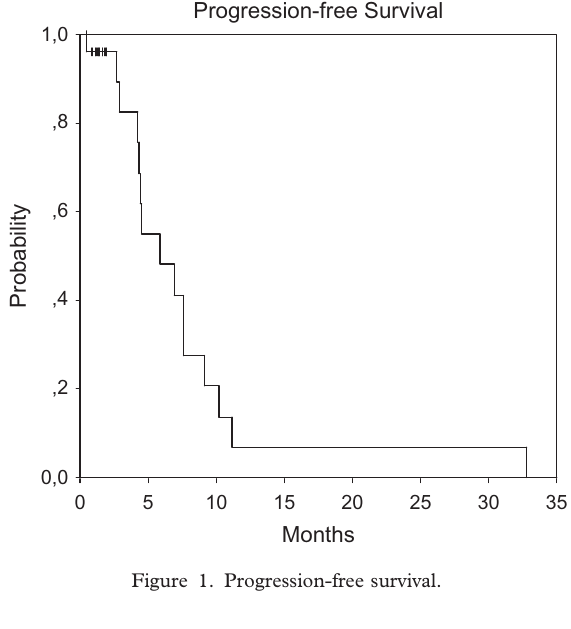
Figure 1. Progression-free survival.